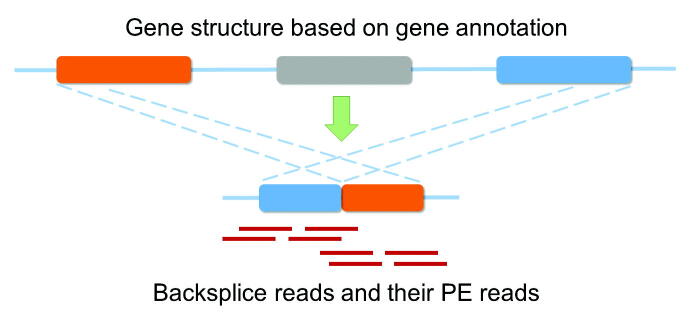
Generation of simulated back-splice reads. A simulated back-splice read generation process is shown in this figure. The orange and blue tiles denote two randomly chosen exons in a gene, and the red line segments denote generated reads. PE, paired end.